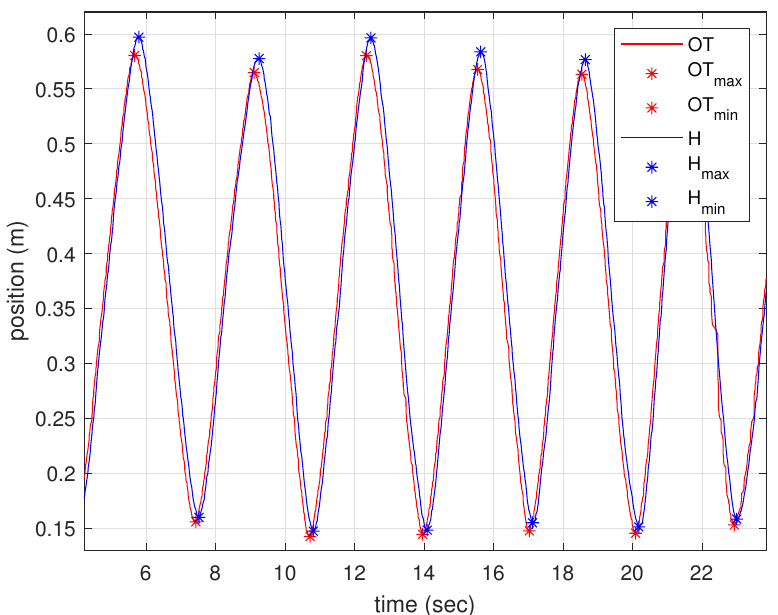
Figure 8. Position signals of OptiTrack (red) and HoloLens 2 (blue).